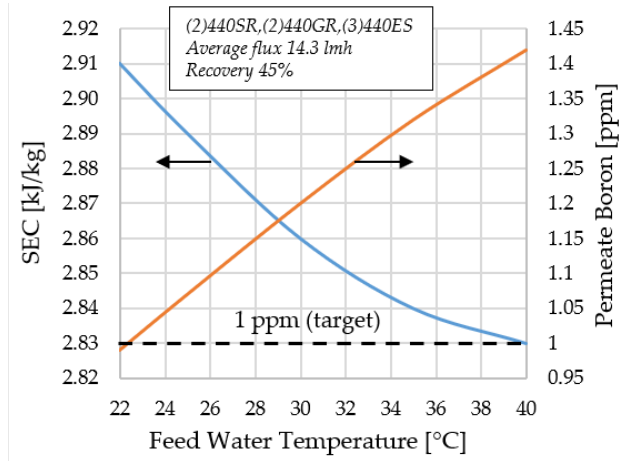
Figure 9. Influence of feed water temperature in Santa Cruz de Tenerife . Sea water composition from Table 2.